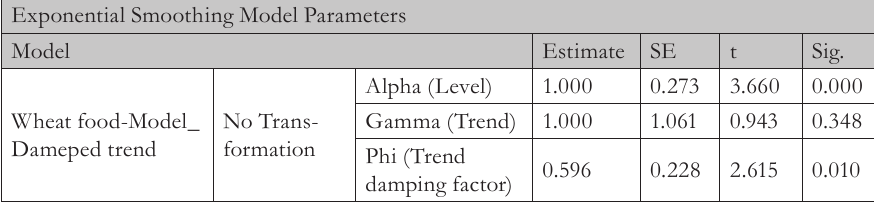
Tab. 6 – Parameters of the forecasting Wheat Food by the Damped trend. Source: